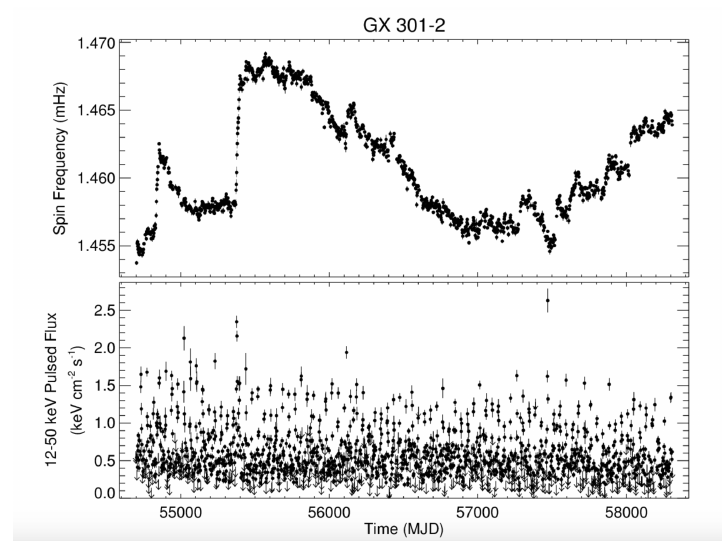
Figure 2. Fermi -GBM pulse periods and flux values for GX301 − 2 as a function of MJD.